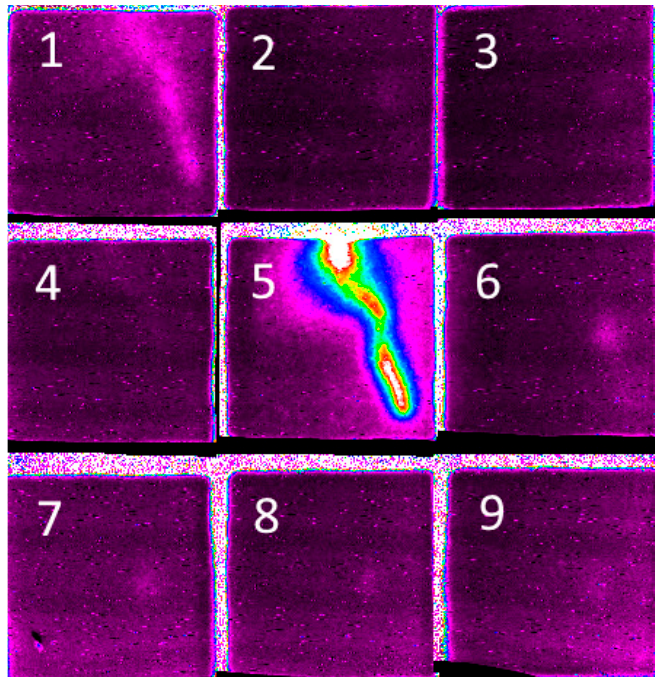
Figure 12. Characteristic dynamics of the formation of the first and repeated discharges from the system of artificial thunderstorm cells of positive polarity with participation of lower and upper groups of model hydrometeors at a more powerful repeated discharge (frame size 85 × 85 cm, frame duration 2.5 μ s, pause between frames 0.1 μ s).